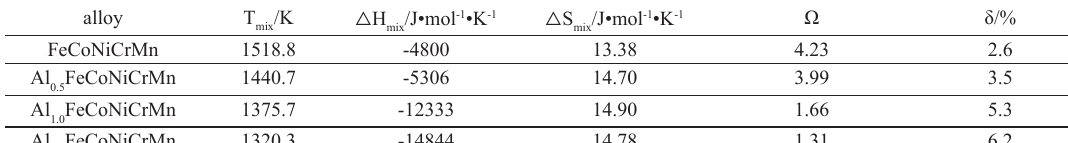
Table 5. Alloy parameter table.